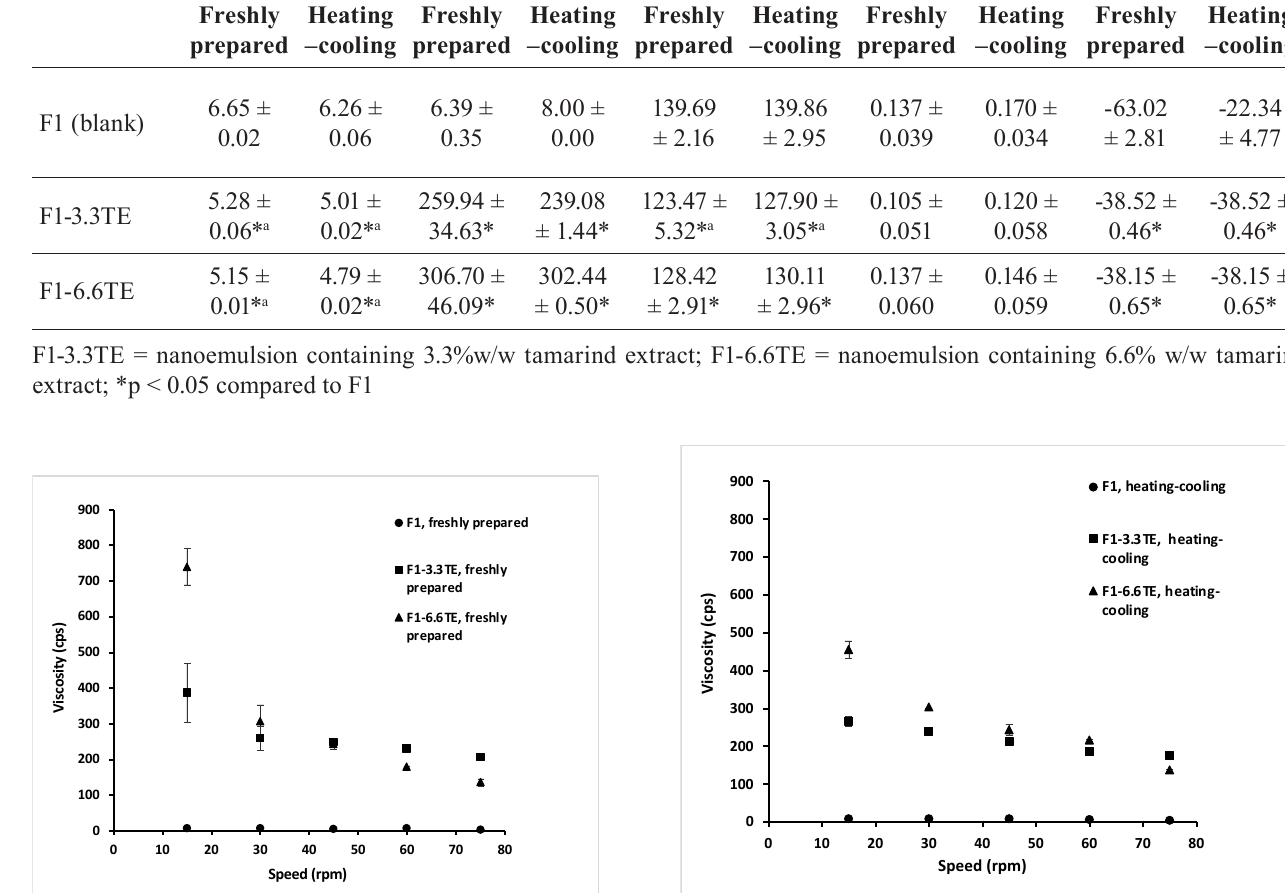
FIGURE 1 - Rheograms of tamarind extract loaded nanoemulsions, F1-3.3TE and F1-6.6TE at freshly prepared (above) and stored at different conditions for 1 month (below), determined at 32ºC. Each point represents mean ± SD, n =3; where n = number of